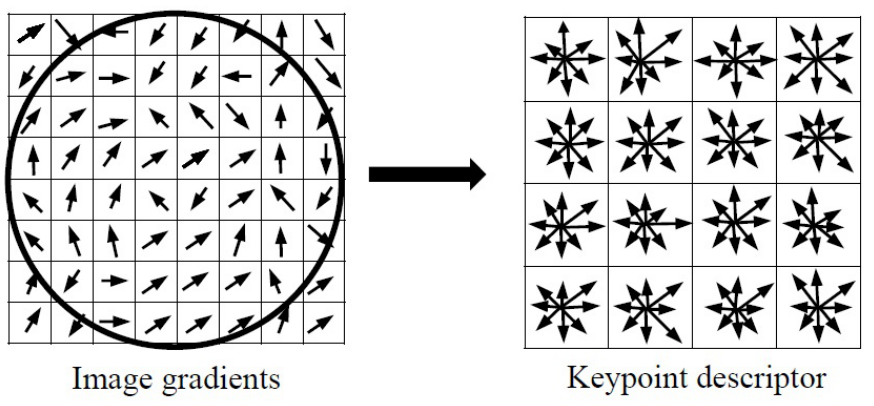
Figure 8. Keypoint descriptor: ( left ) gradient magnitude and orientation are calculated in a region around the keypoint ( right ) a 16 × 16 neighborhood around the keypoint is divided to 4 × 4 subregions. In each subregion the gradient vectors are accumulated into 8-bins orientation